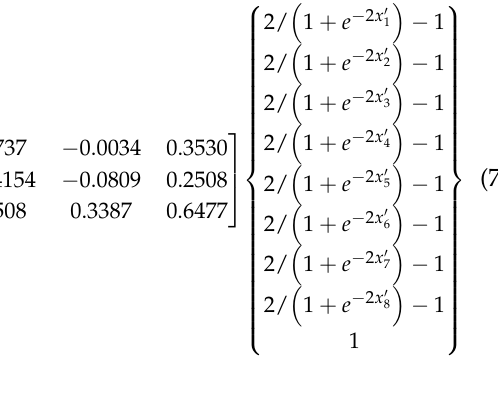
Figure 3. Ranking of significant terms by correlation.